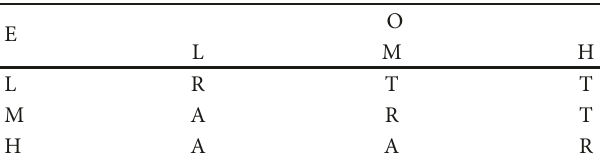
Figure 4: Membershipfunctions for theoffered cellload. Definition of the membership functions: L: low; M: medium; H: High. Table 1: Fuzzy rule table denoting the output P values according to the input E and O values.